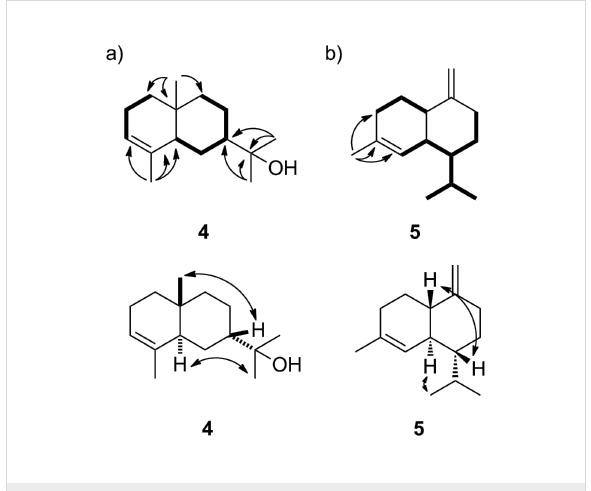
Figure 3: Contiguous spin systems observed by 1 H, 1 H-COSY (bold), key HMBC and NOE correlations for a) 7- epi - α -eudesmol ( 4 ) and b) γ -cadinene ( 5